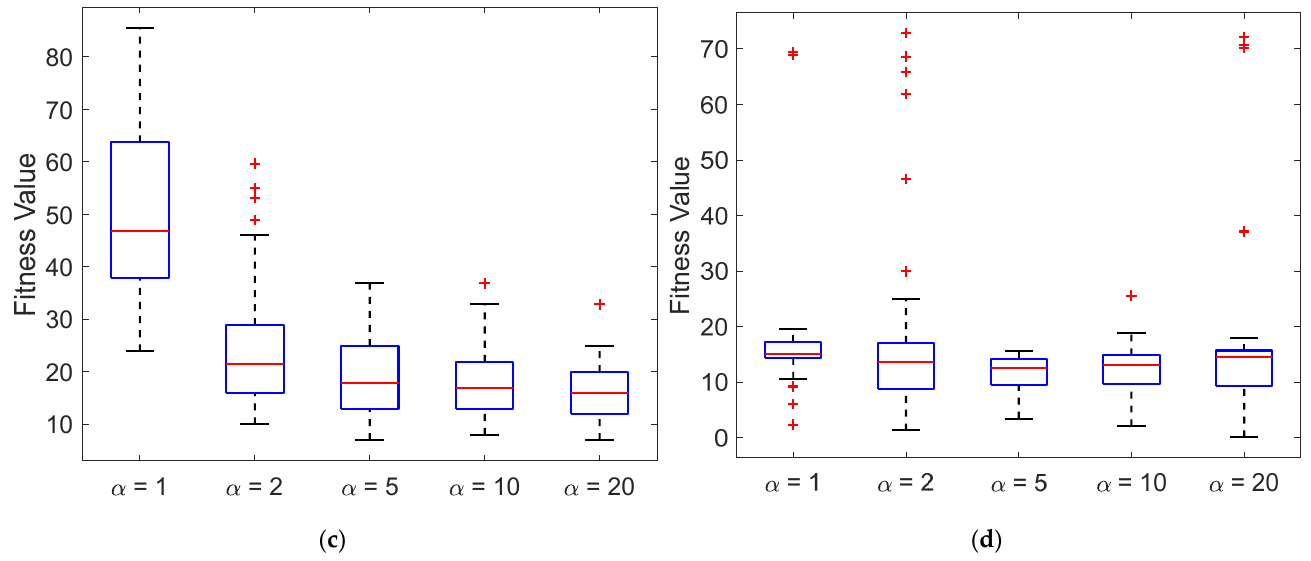
Figure 3. The boxplots for the proposed PSO α for different values of α . ( a ) Ackley. ( b ) Fletcher. ( c ) Rastringin. ( d ) Rosenbrock.